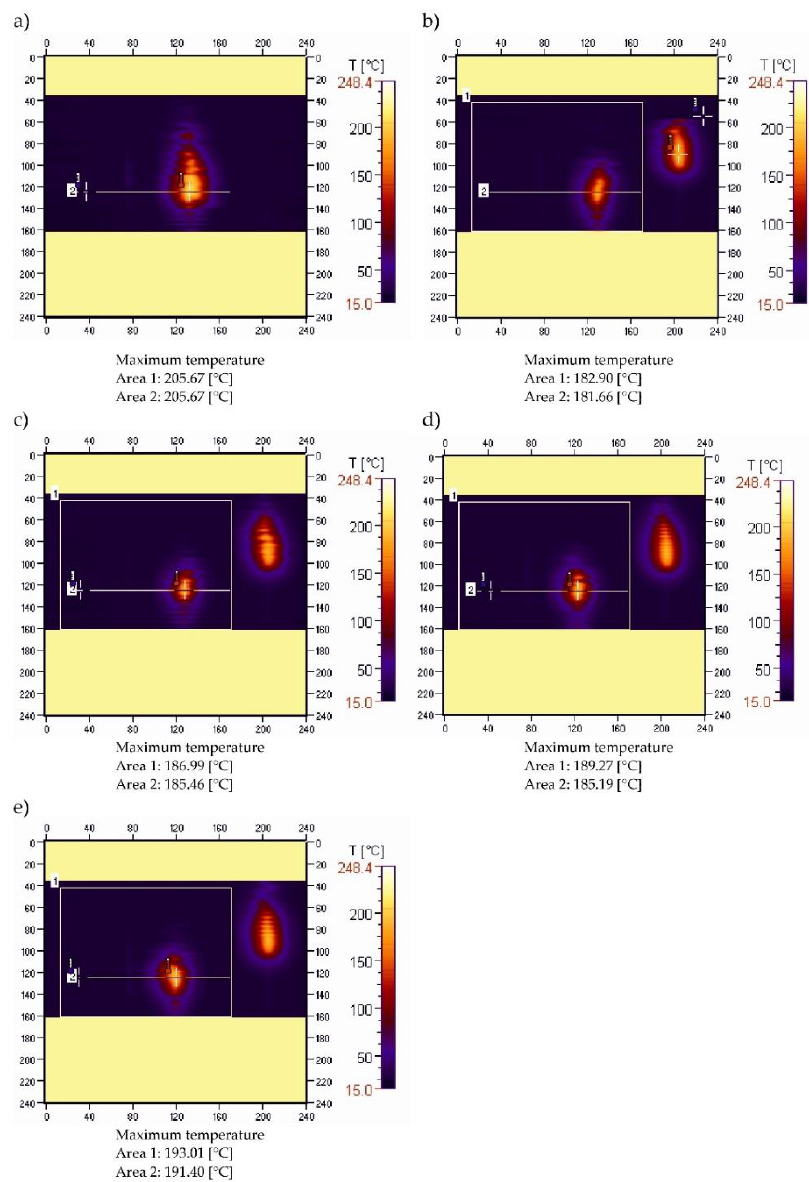
Figure 1. Thermograms of pure PE sample recorded during ignition ( a ) and after: ( b )—15, ( c )—30, ( d )—45, ( e )—60 s after the ignition source was removed.